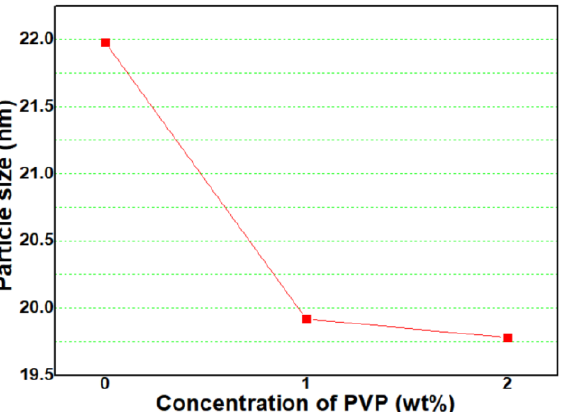
Figure 4. Variation of particle size (calculated by using Equation (1)) of FeO x NPs with concentration of PVP.